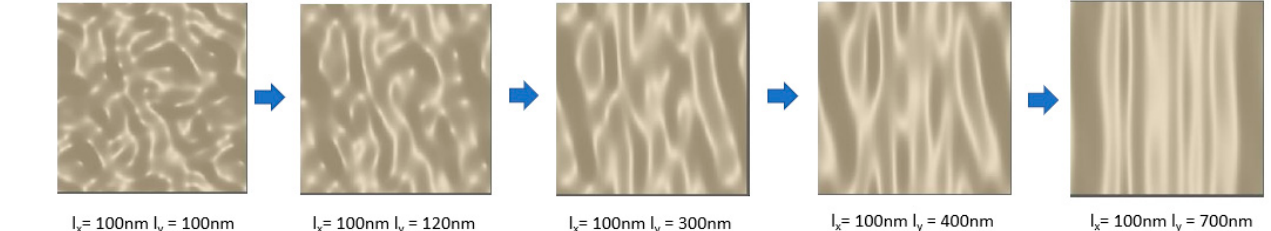
Figure 3. Anisotropic random roughness texture formed by random Gaussians.